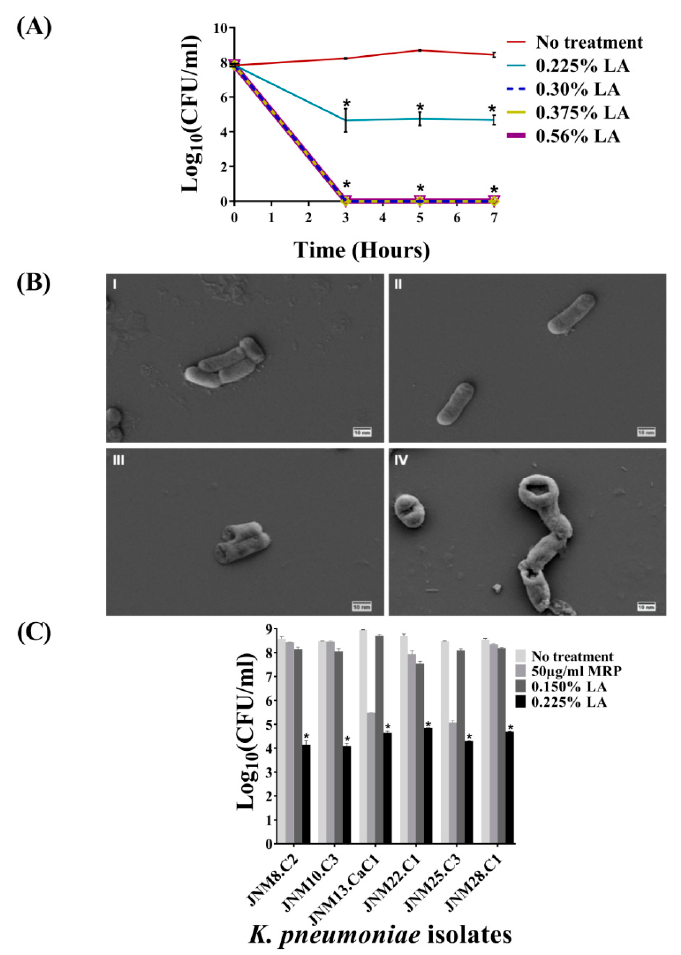
Figure 2. Lactic acid (LA) kills carbapenem-hydrolyzing, third generation cephalosporin resistant K. pneumoniae isolates. ( A ) Mid-logrithmic JNM11.C4 cells were exposed to di ff erent percentages ( v / v ) of lactic acid (LA) for 3, 5 and 7 hours. Experiments were done in duplicate and error bars represent mean ± standard deviation. After 3, 5 and 7 hours the average log (10) CFU/mL values were >8. Treatment with 0.225% (LA) resulted in >3log (10) CFU/mL reduction across time points and no visible growth was observed at 0.30% ( v/v ) LA or above. The differences in log (10) CFU/mL values between untreated and treated JNM11.C4 cells were statistically significant after multiple testing correction. ( B ) Scanning electron micrographs of JNM11.C4 cells at 20,000 × magnification (I) untreated; (II) Meropenem (MRP) treated; (III) 0.150% LA treated; (IV) 0.225% LA treated for three hours. LA treatment resulted in cell membrane damage. (C) Six additional carbapenem-hydrolyzing isolates with di ff erent MRP MIC values were tested for bactericidal e ffi cacy using 0.150% ( v / v ) and 0.225% ( v / v ) LA for 3 hours. Treatment with 0.225% ( v / v ) LA resulted in > 3.5log (10) CFU / ml reduction across isolates and these di ff erences were also found to be statistically significant. Reduction values of ≥ 3log (10) CFU / ml upon treatment with p -values of < 0.05 were considered to be bactericidal (denoted by